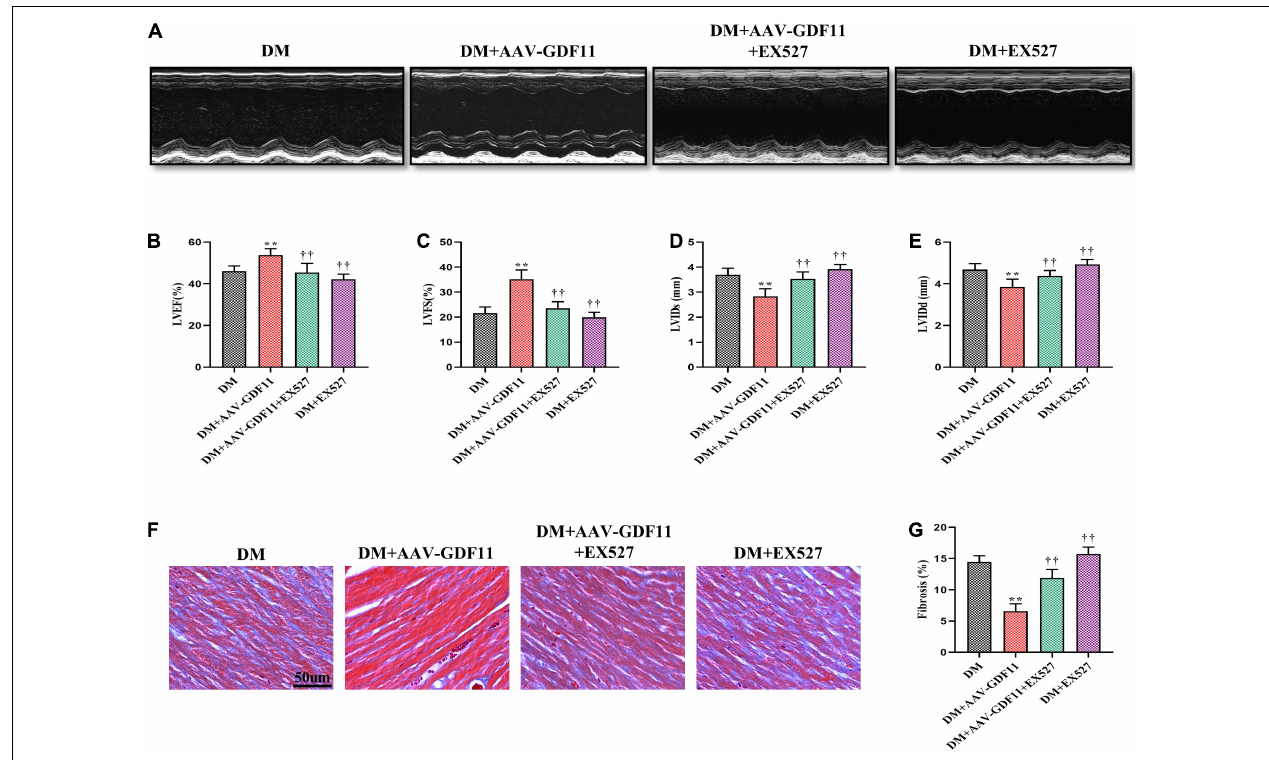
FIGURE 4 | Treatment with EX527 eliminated the positive effects of GDF11 on myocardial function and cardiac fibrosis. (A) Representative images of M-mode echocardiography. (B) Left ventricular ejection fraction (LVEF). (C) Left ventricular fractional shortening (LVFS). (D) Left ventricle internal dimension in systole (LVIDs). (E) Left ventricle internal dimension in diastole (LVIDd). (F) Representative images of Masson’s trichrome staining (scale bar = 50 µ m). (G) Interstitial fibrosis in myocardial sections. Data are presented as the mean ± SEM, n = 6 per group. ** P < 0.01 versus the DM group, †† P < 0.01 versus the DM + AAV-GDF11